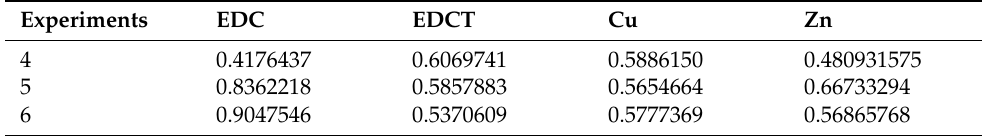
Table 11. Normalized decision matrix.